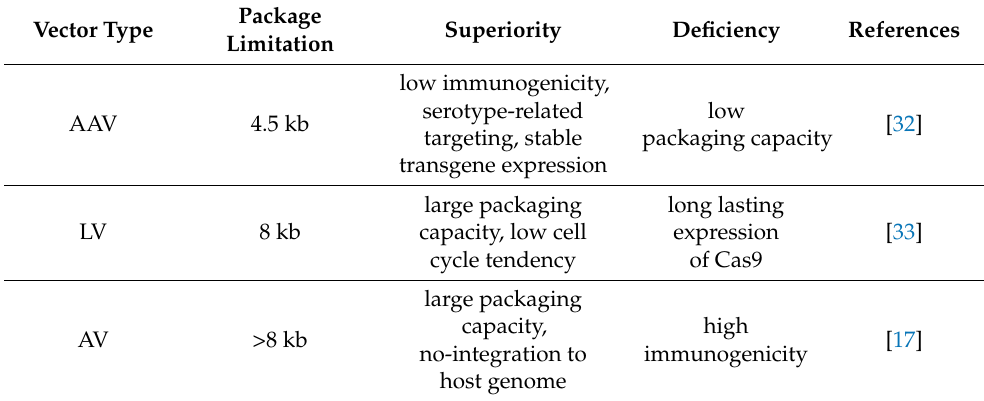
Table 2. Comparison of the viral vectors in clinical trials: AAV, LV, and AV. Vector